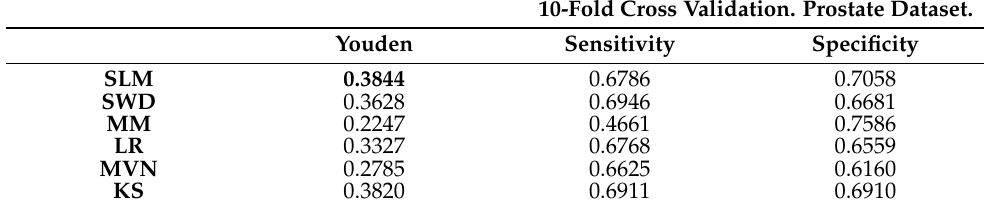
10-Fold Cross Validation. Prostate